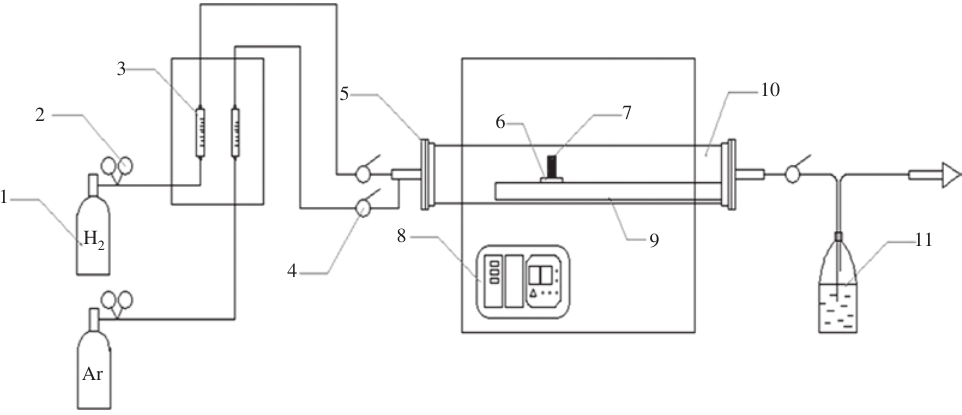
Figure 1: Set-up of the experimental